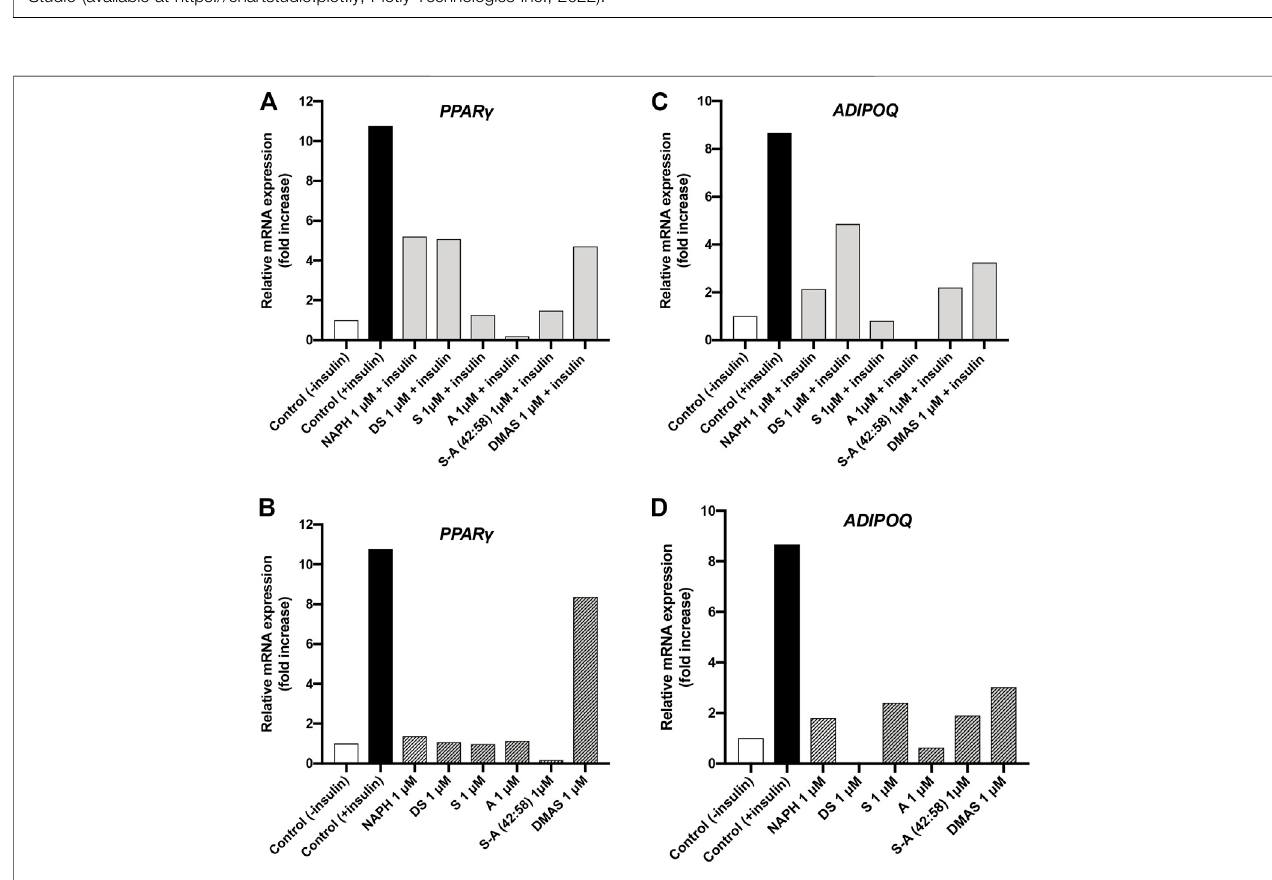
FIGURE7| RelativeconcentrationofmRNAexpressionforPPAR- γ andADIPOQindifferentiated3T3-L1cellstreatedwithA/Sandtheirderivativesinthepresence (A,C) and absence of insulin (B,D) .